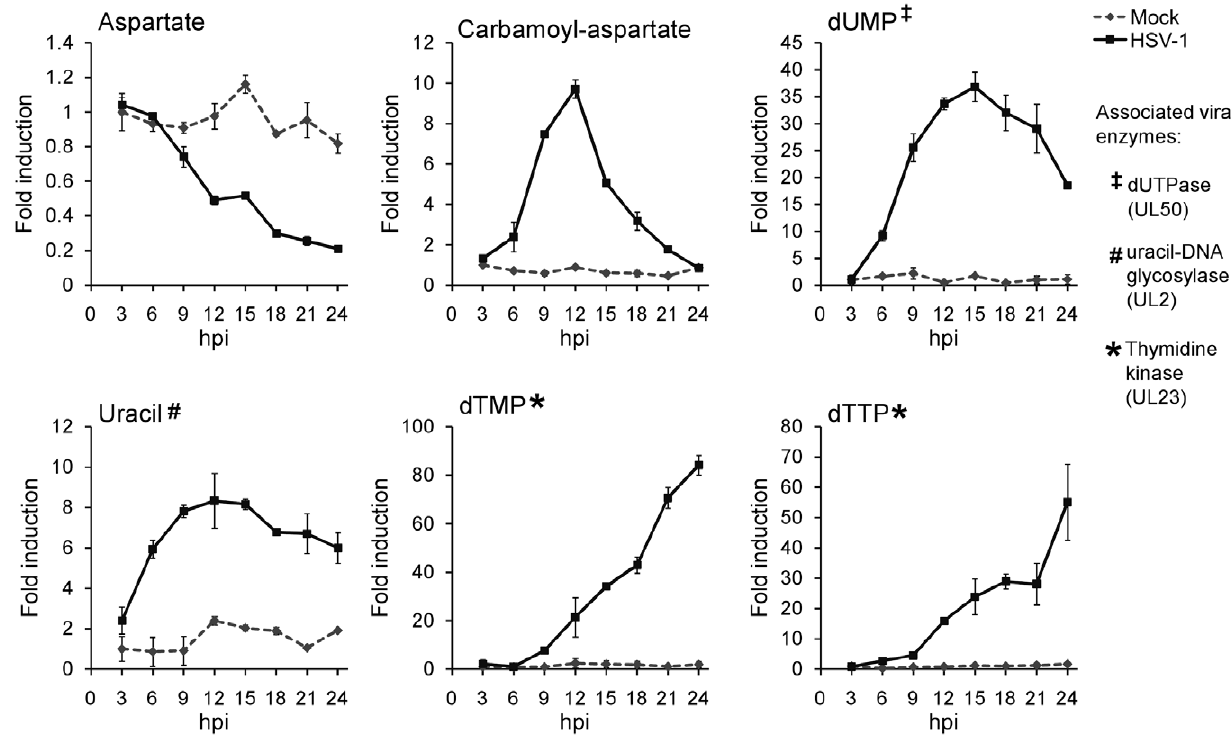
Figure 5. Upregulation of pyrimidine nucleotide biosynthesis during HSV-1 infection. Individual metabolite abundance in HSV-1-infected and mock-treated quiescent HFFs. To show separately the trend in mock versus infected cells, metabolite concentrations are expressed relative to the average level measured in mock-infected cells at 3 h post mock treatment (mean 6 2 s.e.; n=2).